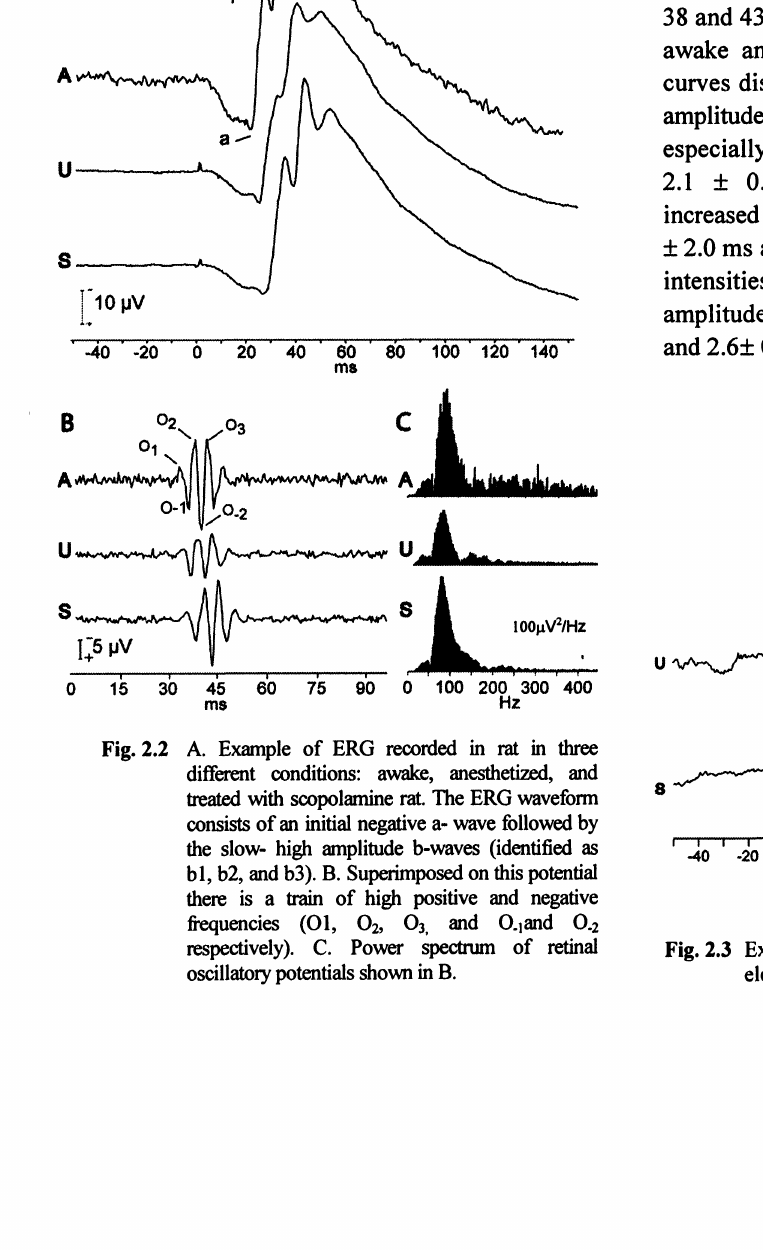
Fig. 2.3 Example of ERG recorded using the DTL acute electrode alter both urethane and